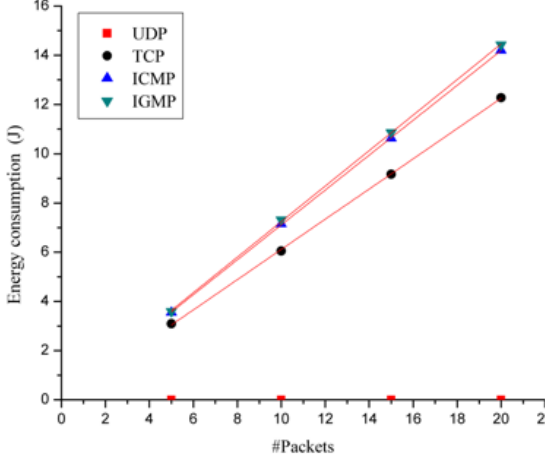
Figure 7. Energy consumed vs. packet